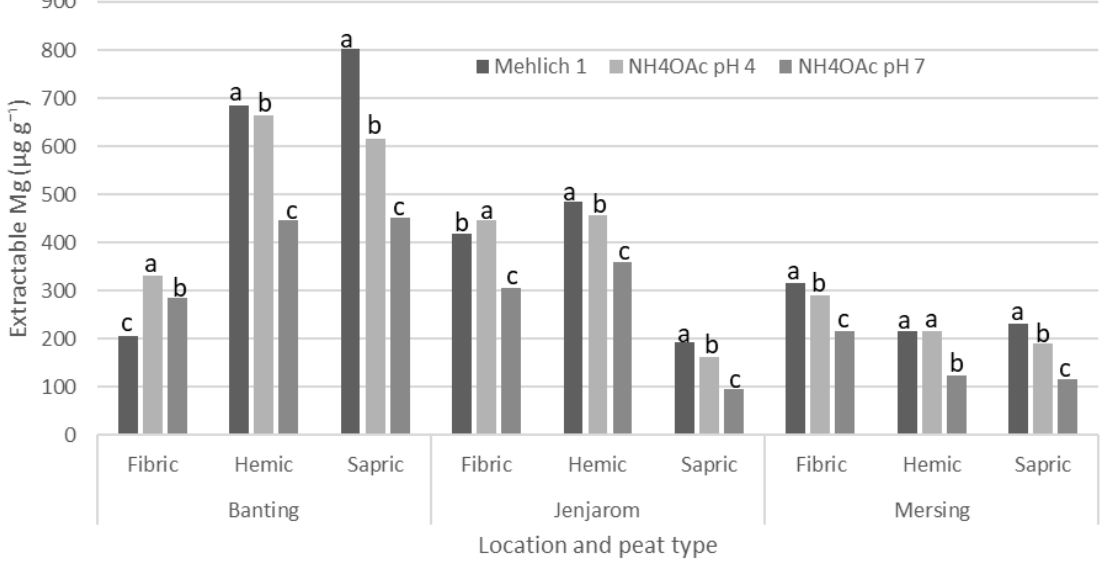
Figure 3. Comparison of the amounts of Mg 2+ obtained, using three different extractants, from Fibric, Hemic and Sapric peat collected at three different locations (Banting, Jenjarom, Mersing) in peninsular Malaysia. Different letters (per peat type and location) indicate significant differences between means (Tukey’s test at P =